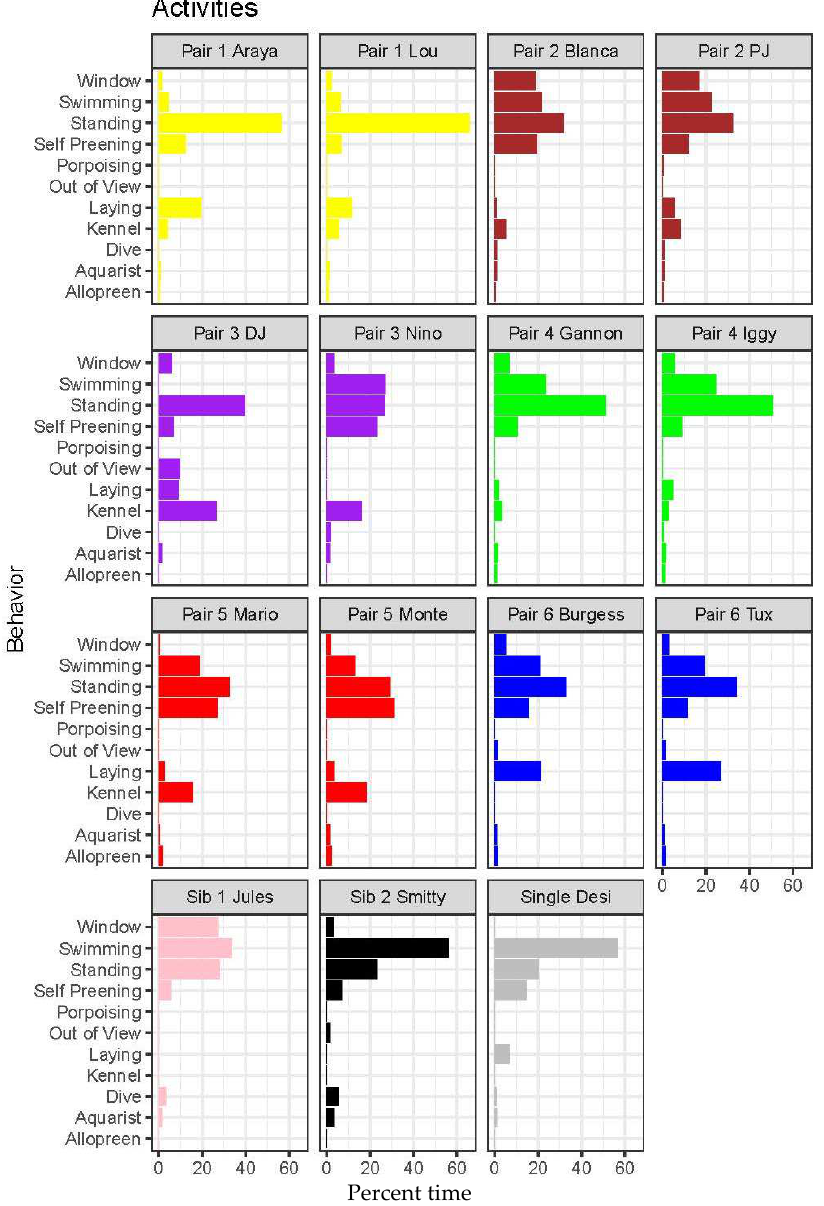
Figure 2. Activity budgets of penguins based on data collected with Animal Behaviour Pro. The definitions of each behavior may be found in Table 2.